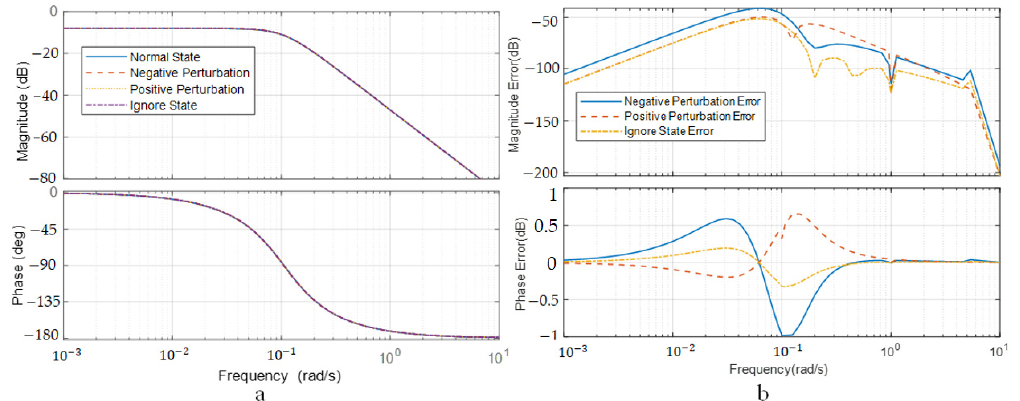
Figure 5. Bode Plot and Deviation Curve of Pitching Channel in Perturbation State of Moment of Pitching Aerodynamic Stabilization: (a) Bode plot of the pitching channel in the perturbation state of the pitch aerodynamic stability moment, (b) amplitude frequency and phase frequency deviation curves of the pitching channel in the perturbation state of the pitch aerodynamic stability moment.